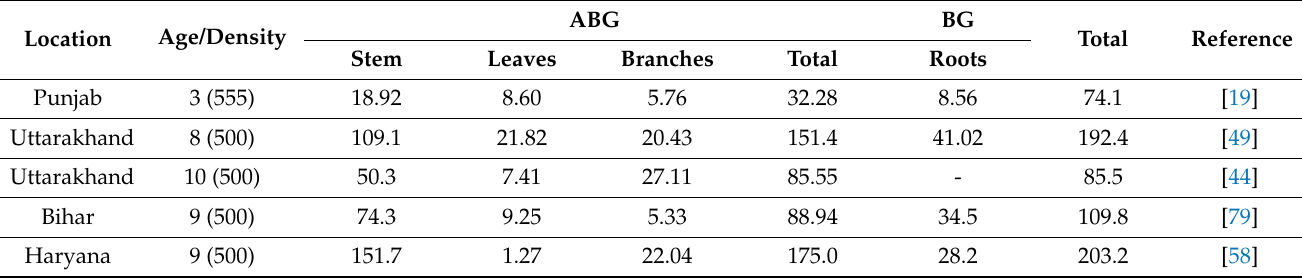
Table 5. Allocation of carbon in different components of poplar tree